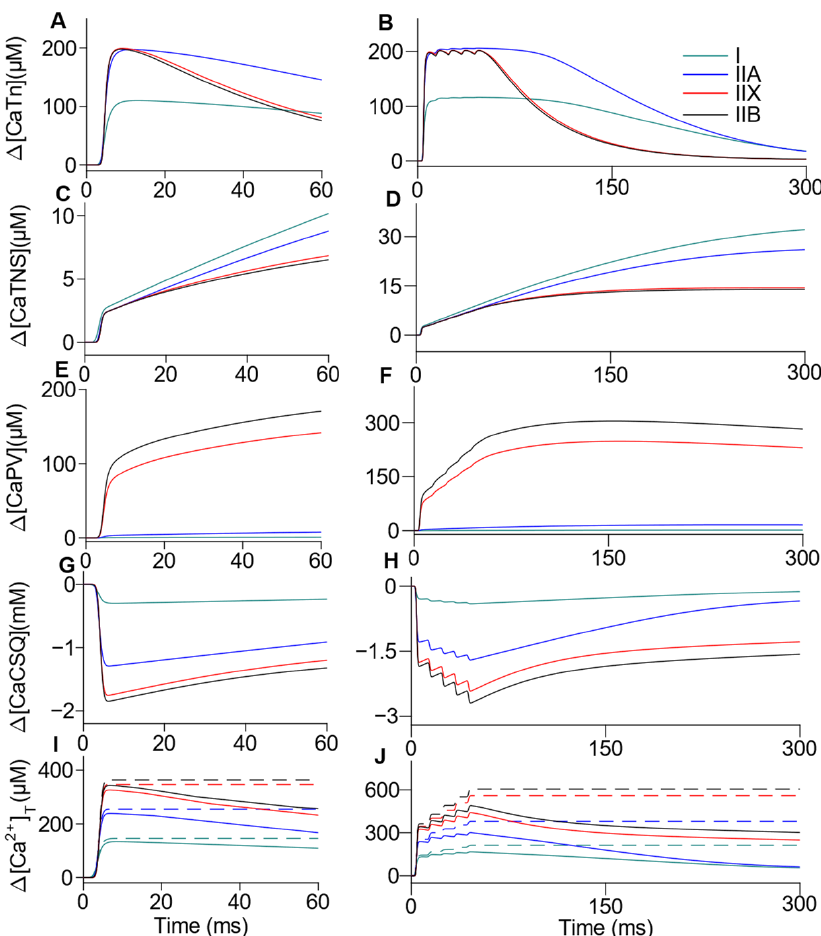
Figure 3. Simulation of single and tetanic Ca 2+ transients buffering. The ∆ [Ca 2+ ] coupled to the sarcoplasmic buffers: Tn ( A , B ), non-specific sites (TNS) ( C , D ), and PV ( E , F ); and the SR buffer: calsequestrin (CSQ) ( G , H ) is shown for single (left column) and tetanic (right column) transients. The total [Ca 2+ ] in the sarcoplasm (solid line), was calculated as the sum of the ∆ [Ca 2+ ] in both free and bound forms, whereas the total [Ca 2+ ] released (dashed line), is the numerical integration of J Rel ( I , J ).